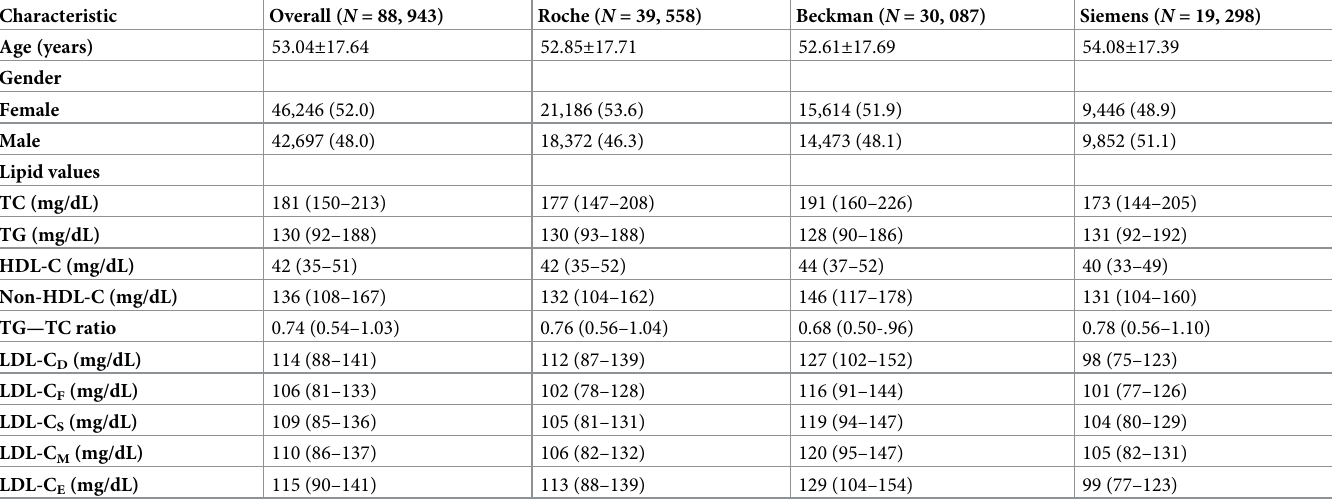
Table 1. Study population characteristics. Characteristic